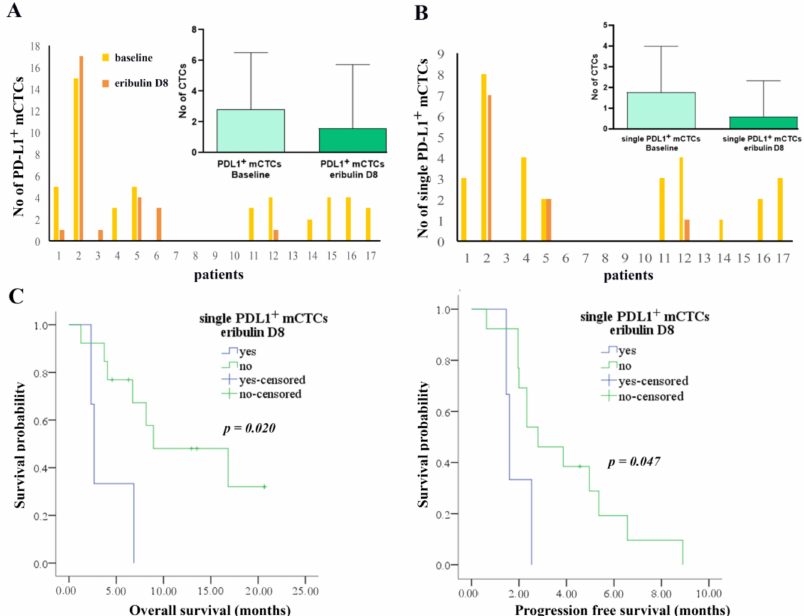
Figure 4. Detection and clinical significance of PD-L1 + mCTCs subpopulations on D8 of eribulin treatment. ( A ) Number of PD-L1 + mCTCs at baseline and on day 8 of the first administration of eribulin. Inset shows mean values of CTCs detected in patients ( p = 0.034). ( B ) Number of single PD-L1 + mCTCs at baseline and on day 8 after the first administration of eribulin. Inset shows mean values of CTCs detected in patients ( p = 0.008). ( C ) Kaplan-Meier analysis of overall survival (OS) and progression-free survival (PFS) according to the detection or not of single PD-L1 +